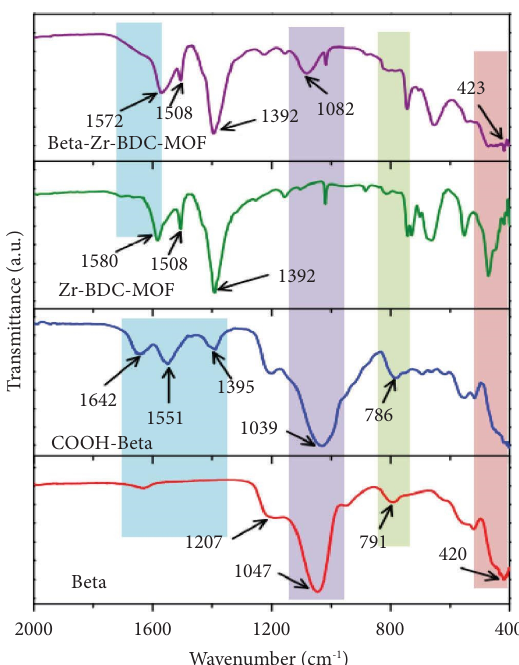
Figure 14: FTIR spectra of parent materials and their composite adopted from